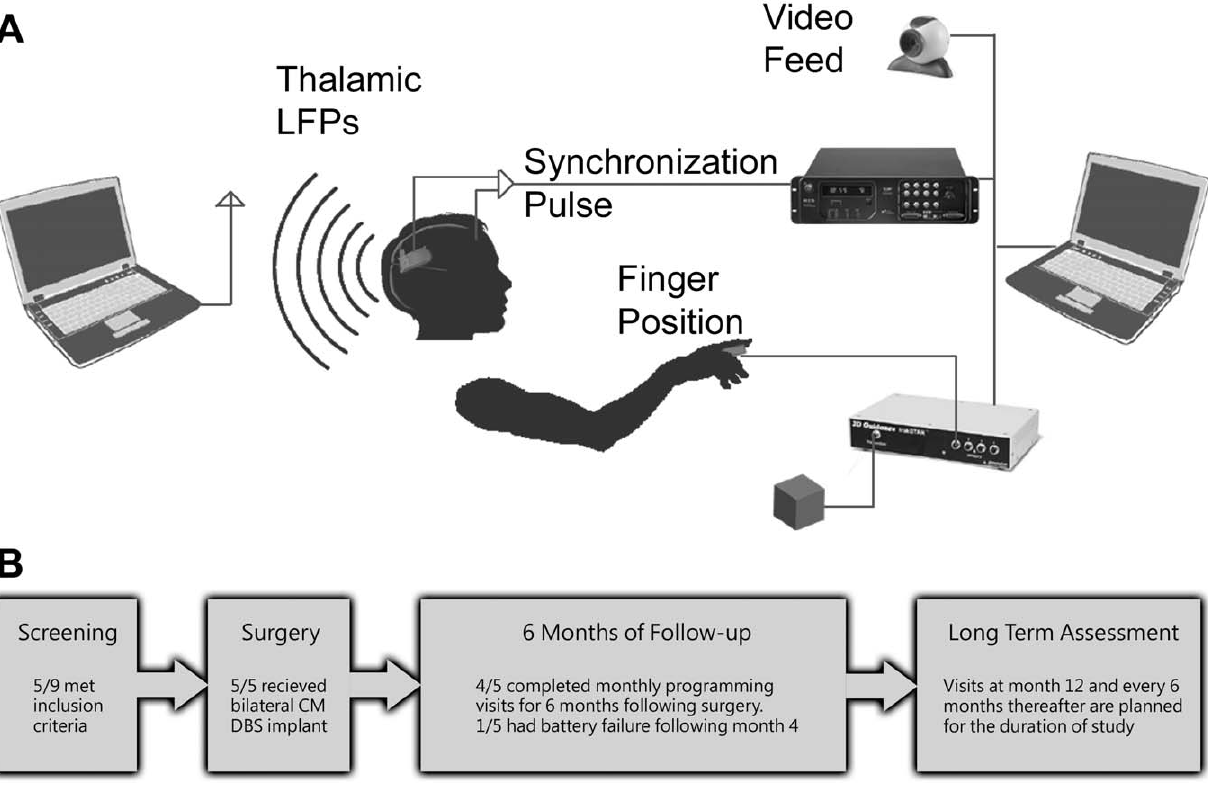
Figure 1. Study design. A) Experimental testbed for synchronous recording of local field potentials and tic expression. B) Data collection timeline.